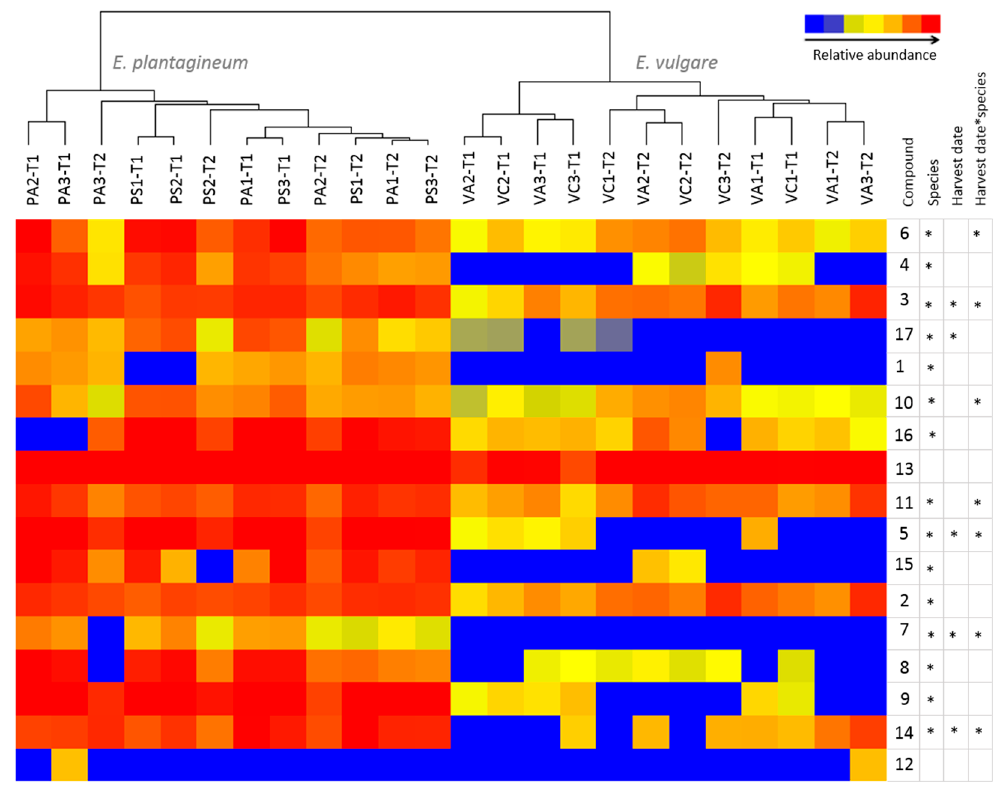
Figure 6. Comparison of abundance of selected pyrrolizidine alkaloids and their N -oxides in Echium plantagineum and E. vulgare plants grown in uniform conditions in the glasshouse. Hierarchical clustering algorithm and Euclidean distance metric were used on normalized abundance values.